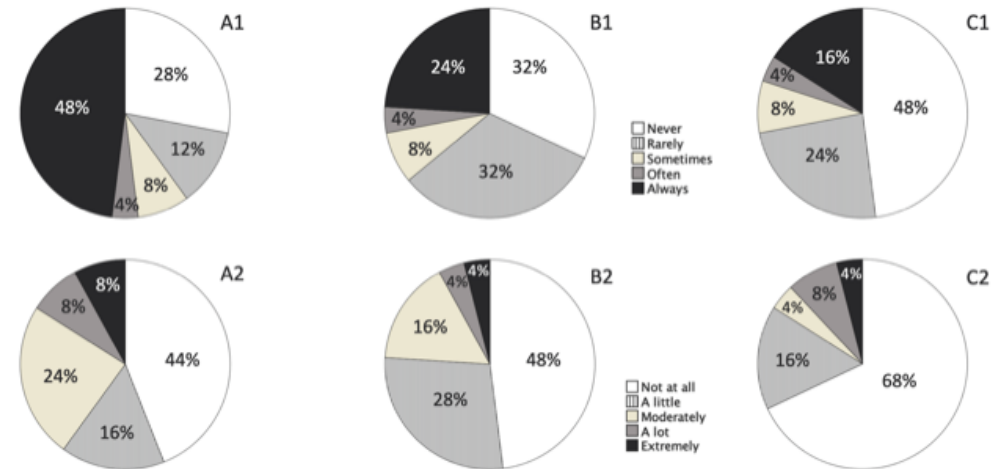
Figure 5. Pie charts showing the distribution of reported visual experience within the last 7 days (upper row) and level of impairment (lower row) of halos ( A ), starbursts ( B ), and glare ( C ), as per the PRVSQ. ( A1 ) percentage of halos symptoms; ( A2 ) subjective level of halos; ( B1 ) percentage of starbursts symptoms; ( B2 ) subjective level of starbursts; ( C1 ) percentage of glare symptoms; ( C2 ) subjective level of glare. The legends in the middle apply to all the pie charts within each row, re- spectively.